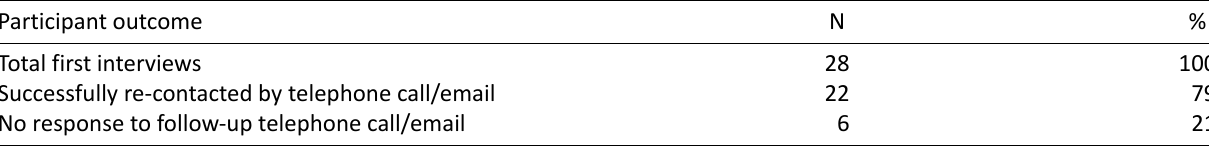
Table 2. Outcome of follow-up contact (N = 22 successful contacts, 2–3 months after first interview). Participant outcome Total first